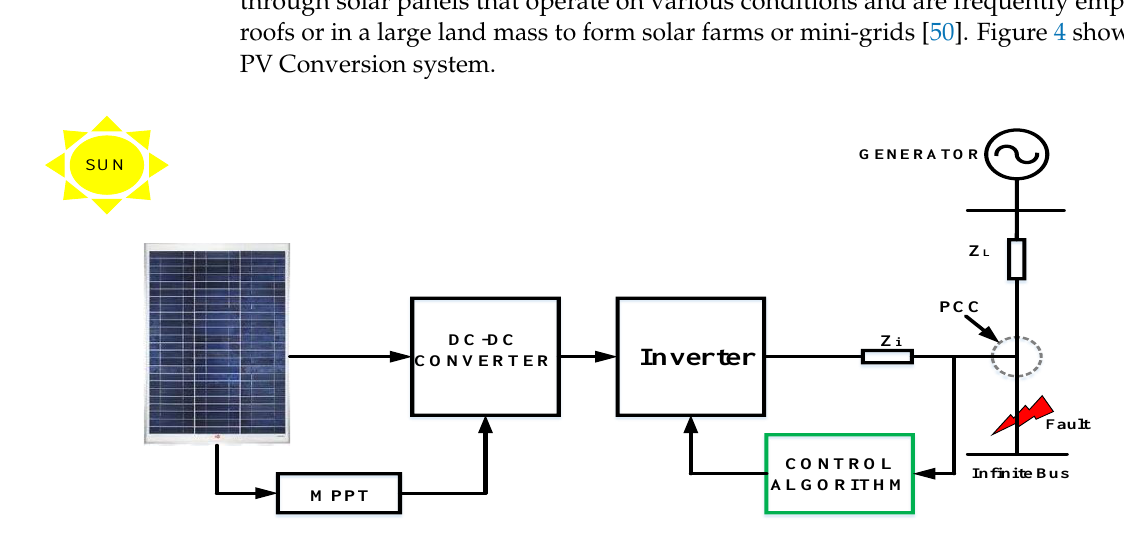
Figure 4. A Solar PV Conversion system [51].